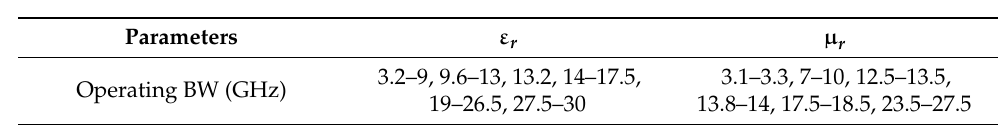
Table 3. The characteristics of the MTM